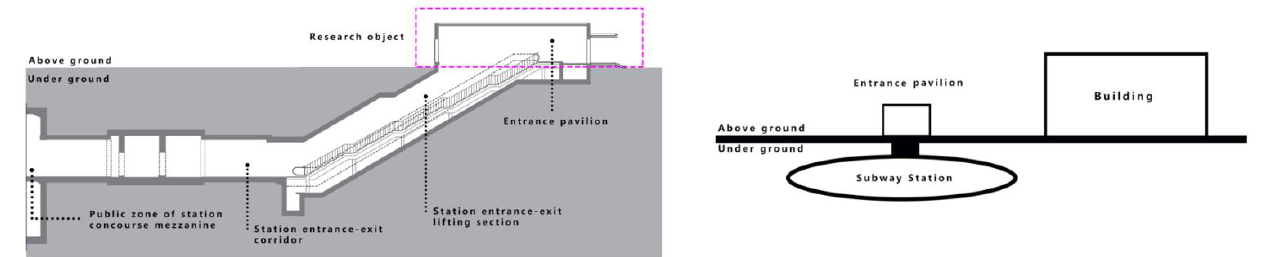
Figure 2. Schematic diagram of research object.